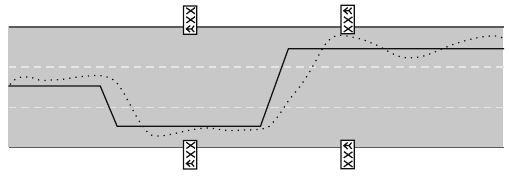
Figure 6: Lane Change Test deviation analysis [24].